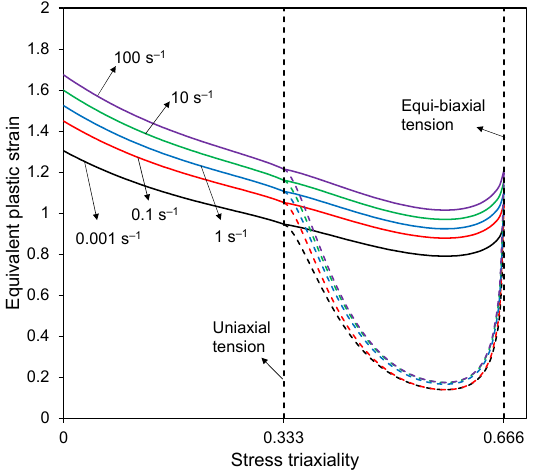
Figure 8. Ductile fracture and localized necking loci under proportional loading paths at different strain rates.